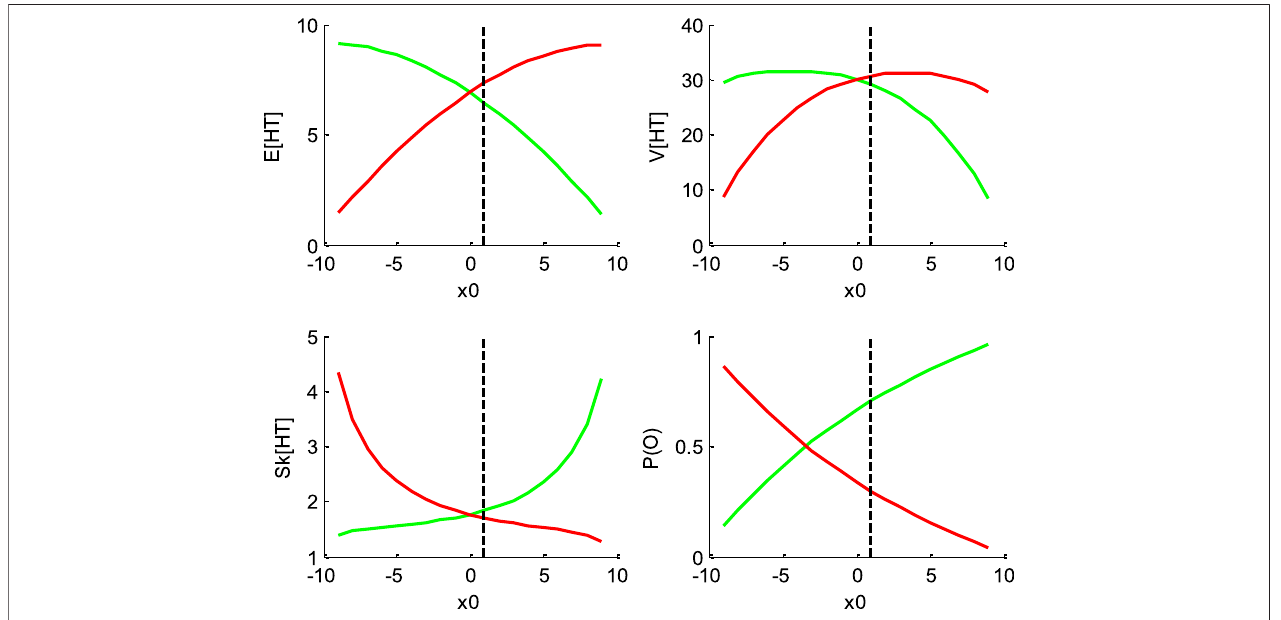
FIGURE 1 | Impact of initial bias x 0 . In all panels, the color code indicates the decision outcomes (green: “ up ” decisions, red: “ down ” decisions). The black dotted lineindicatesthedefaultparametervalue(foreaseofcomparisonwithother fi guresbelow).Upper-leftpanel:meanhittingtimes( y -axis)asafunctionofinitialbias( x -axis). Upper-right panel: hitting times ’ variance ( y -axis) as a function of initial bias ( x -axis). Lower-left panel: hitting times ’ skewness ( y -axis) as a function of initial bias ( x -axis). Lower-right panel: outcome ratios ( y -axis) as a function of initial bias ( x